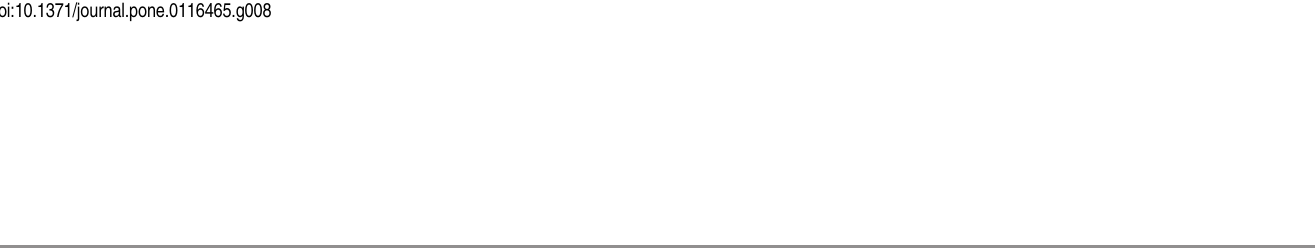
Fig. 8. Phylogenetic tree showing the relationships of 16S rDNA sequences of 33 Faecalibacterium prausnitzii isolates from our group with other bacteria of the belonging to the same order; Ruminococcaceae (black), Syntrophomonadaceae (green), Peptostreptococcaceae (blue), Clostridiaceae and Lachnospiraceae